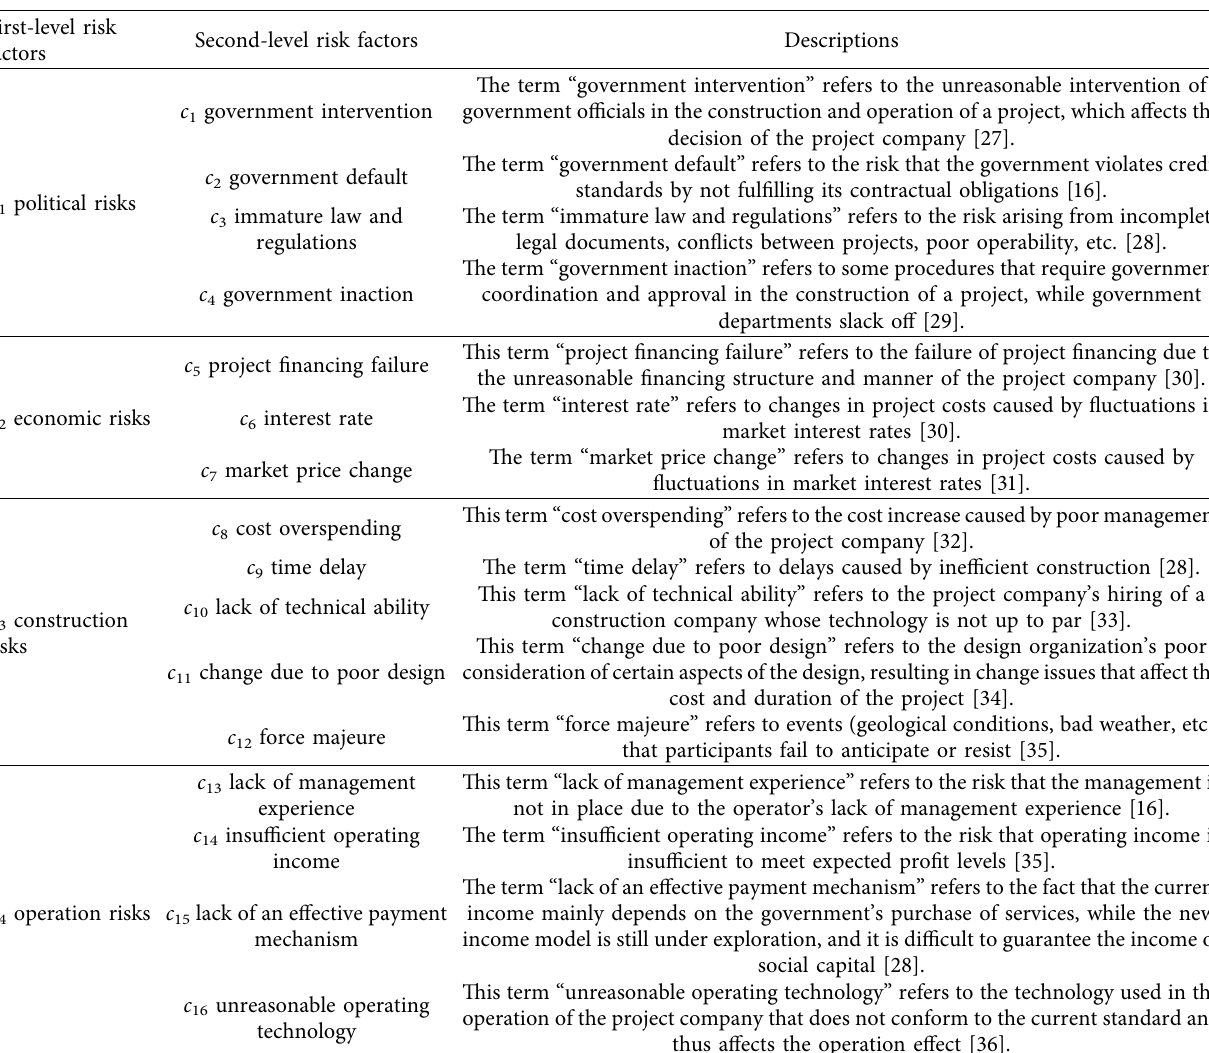
Table 2: Risk evaluation index system of sponge city PPP projects.